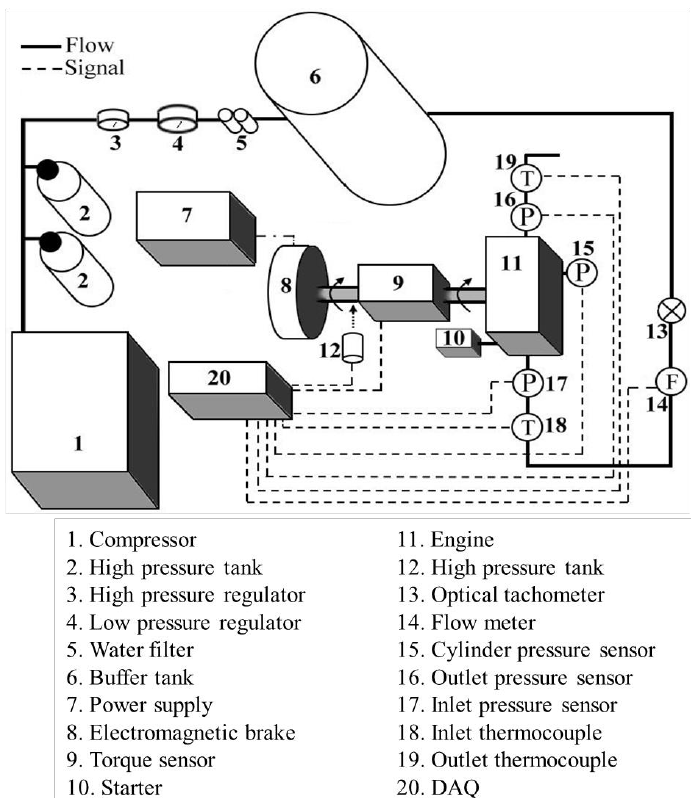
Figure 1. Experimental setup of the compressed air engine test